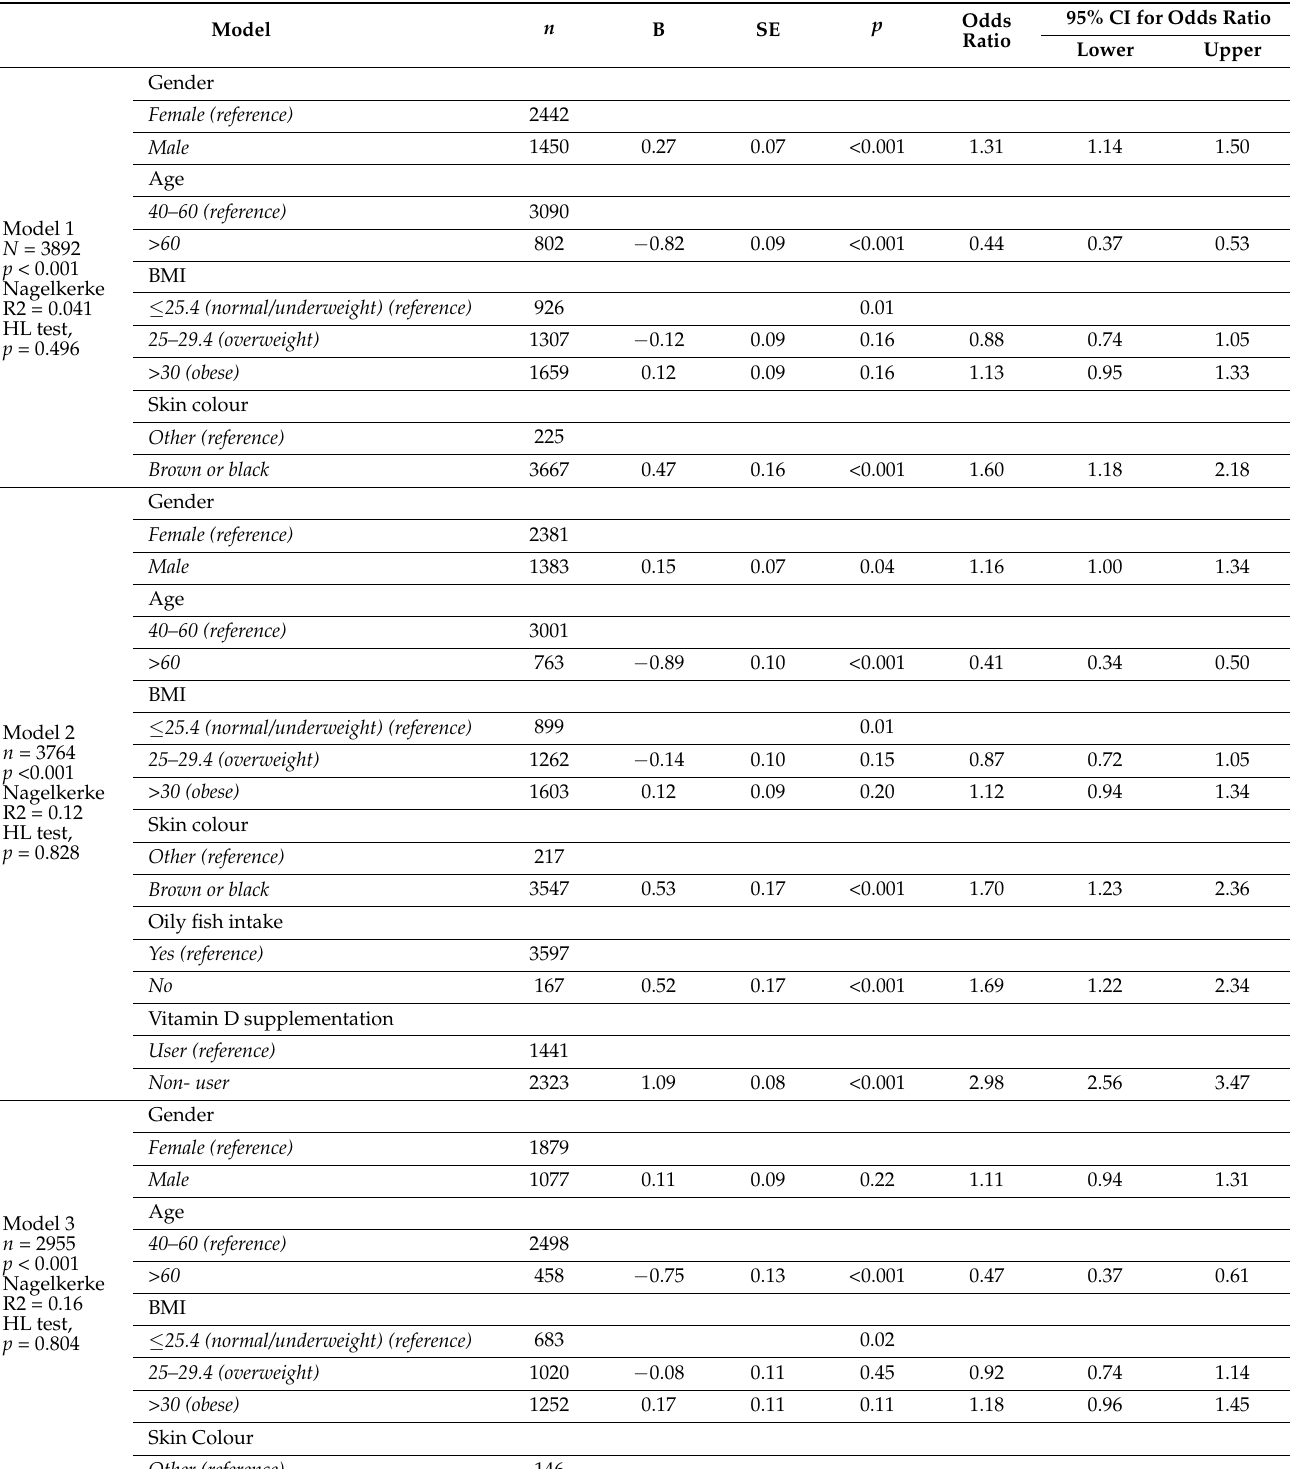
Table 5. Prediction of vitamin D deficiency (<25 nmol/L) in the UK Biobank African-Caribbean participants.